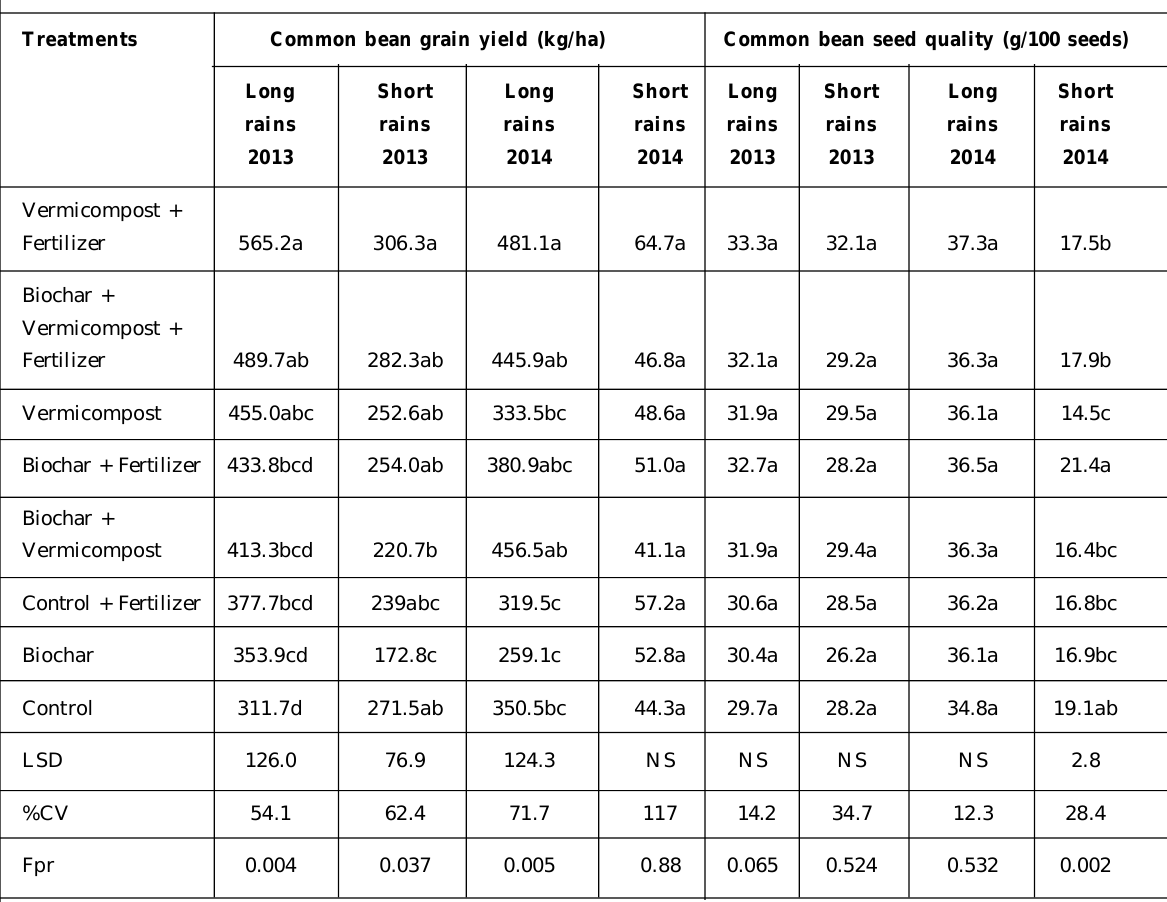
Table 16: Effect of biochar and vermicompost on common bean yields (kg/ha) and seed quality (weight per 100 seeds) across all the four seasons in 2013 and 2014